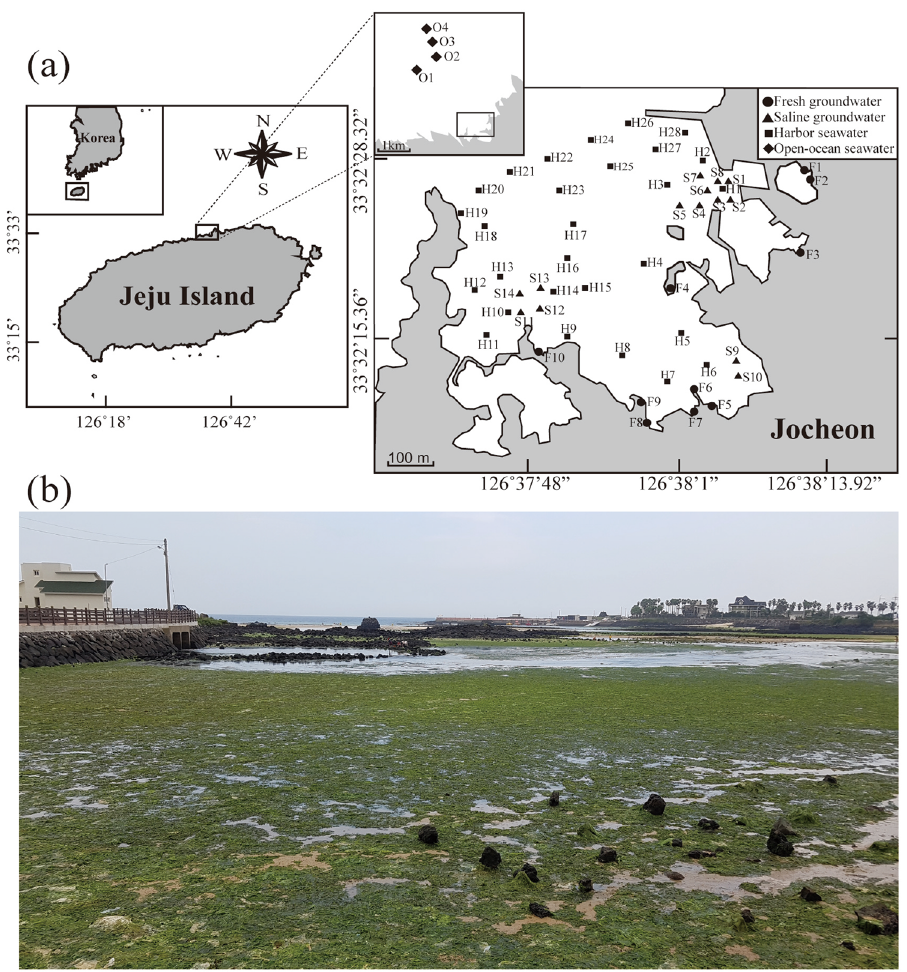
Figure 1. ( a ) The maps showing the sampling stations in coastal area of Jocheon, Jeju Island. The filled circles, triangles, squares and diamonds represent fresh groundwater (Sts. F1-F10), saline groundwater (Sts. S1-S14), harbor seawater (Sts. H1-H28), and open-ocean seawater (Sts. O1-O4), respectively. Maps were created using Adobe Illustrator CC (http://www.adobe.com/illustrator). ( b ) Photograph of massive green tide development in Jocheon, Jeju